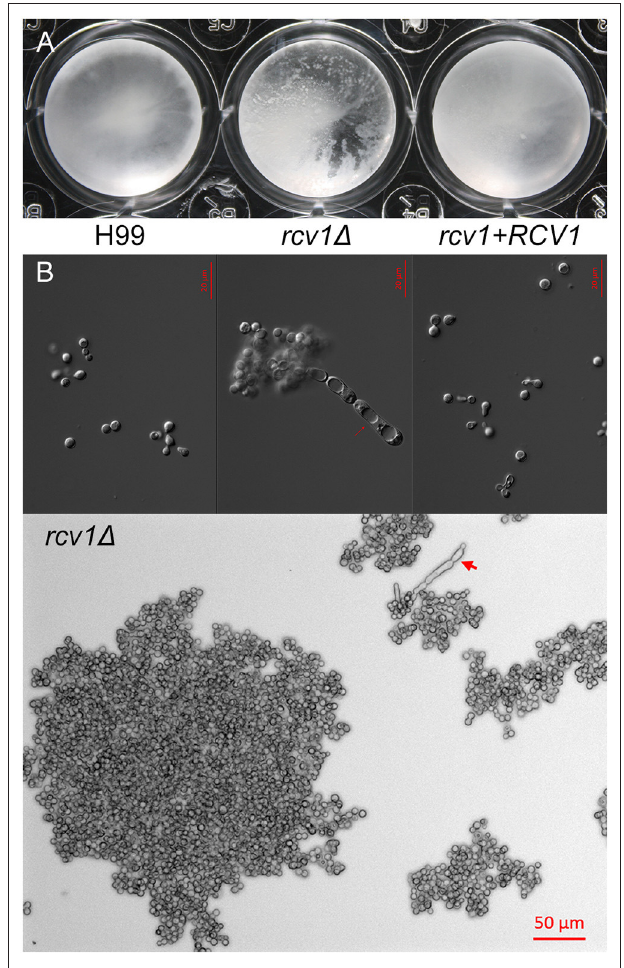
FIGURE 3 | The rcv1 ∆ strain shows heavy clumping under certain conditions. (A) Clumping of cells becomes macroscopically apparent for the mutant strain after 9 days at 37 ◦ C on Sab/MOPS. (B) Upper panel: DIC micrographs of yeast cells from the three strains after 7 days on CO 2 -independent medium at 37 ◦ C. Notice the elongated cells with prominent vacuoles on the mutant. Lower panel: large clump of rcv1 ∆ cells on same conditions. Arrows, pseudohypha-like